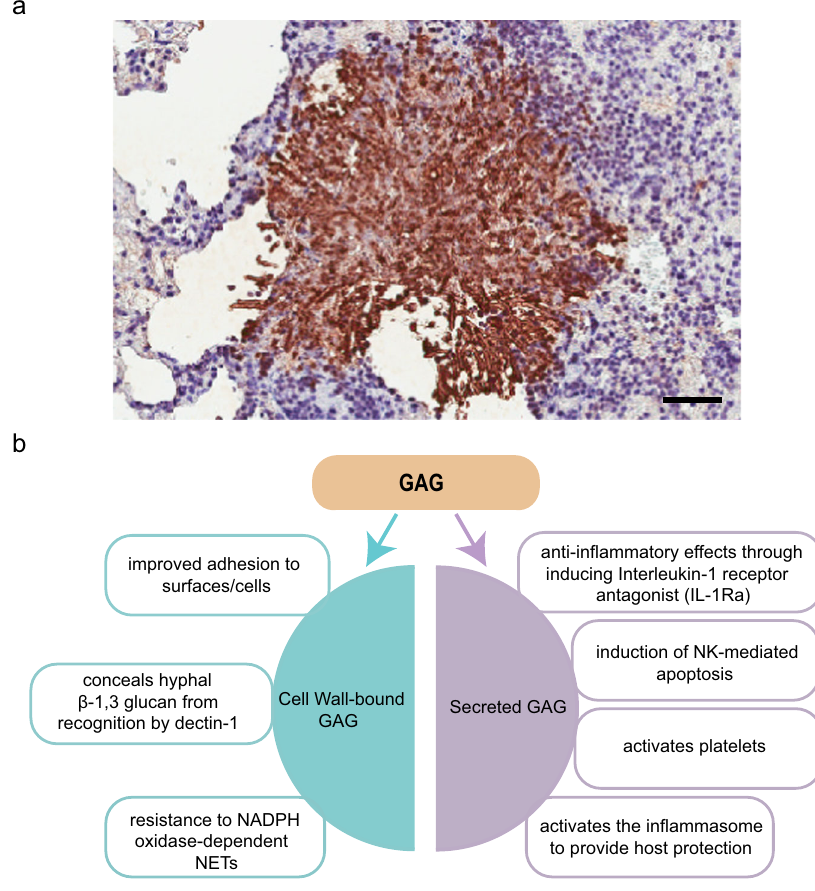
Fig. 1 A. fumigatus produce GAG in vivo and the multiple roles of GAG in pathogenesis. a Immunohistochemistry of pulmonary tissue from an immunocompromised mouse infected with A. fumigatus and stained with an anti-galactosaminogalactan antibody. Brown indicates accumulation of galactosaminogalactan-containing bio fi lm matrix surrounding hyphae growing within pulmonary tissues. b Both cell wall- bound GAG and secreted GAG play multiple roles in Aspergillus pathogenesis. Scale bar: 150 μ